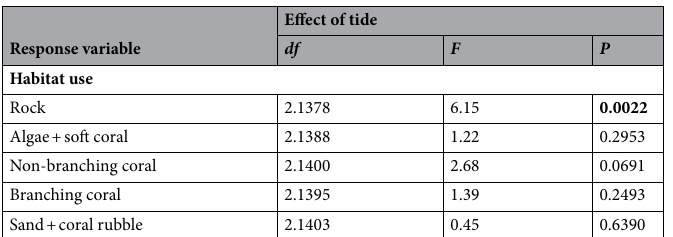
Table 1. Results of mixed model analyses on the effects of tide on characteristics of habitat used by sea snakes ( Emydocephalus annulatus ). Each habitat variable was ln-transformed prior to analysis. Snake ID was included as a random effect in all five models. Bold font indicates significant values ( P < 0.05).